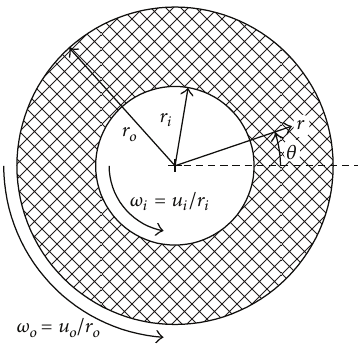
Figure 1: Schematics of present